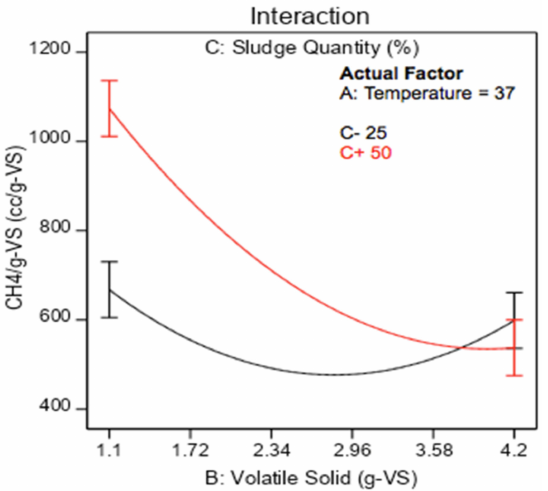
Figure 18. Interaction plot shows the effect of interaction between volatile solid and sludge quantity on CH 4